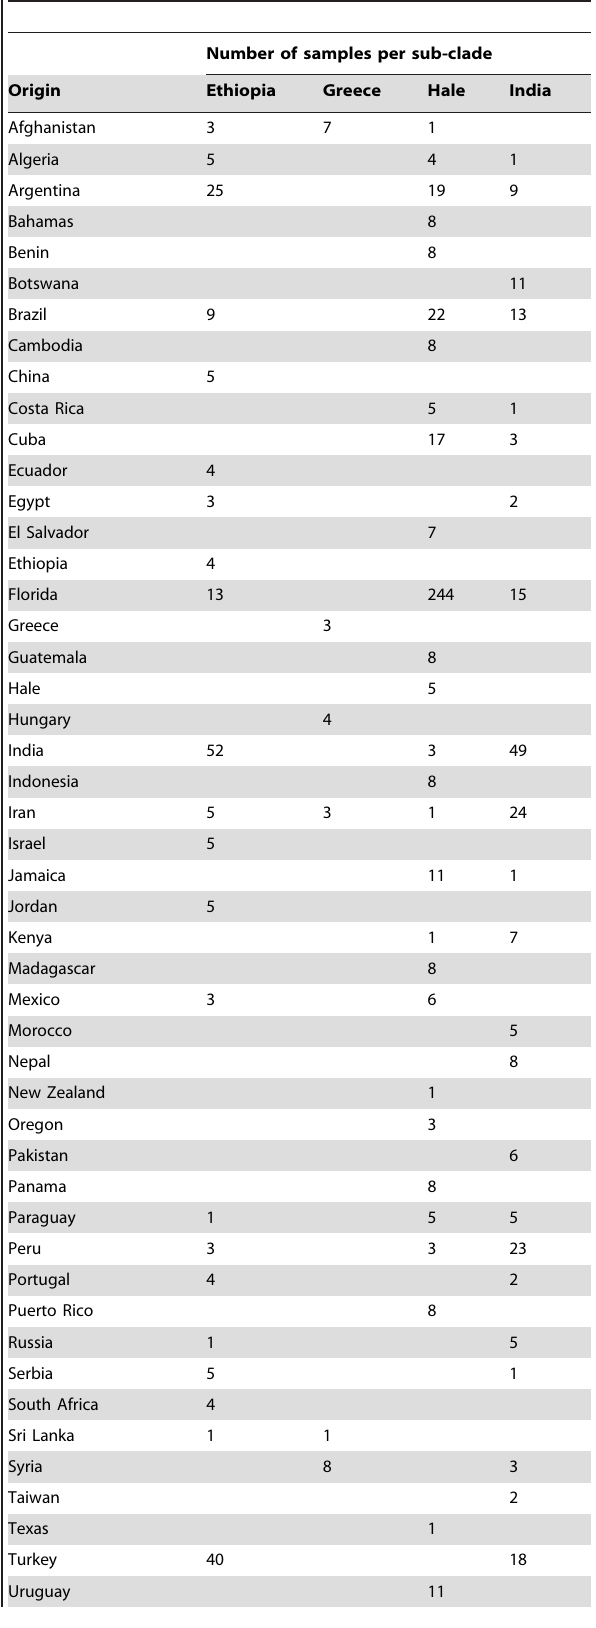
Table 2. Country or state of origin and the chloroplast sub- clade for 894 Ricinus communis samples collected worldwide.